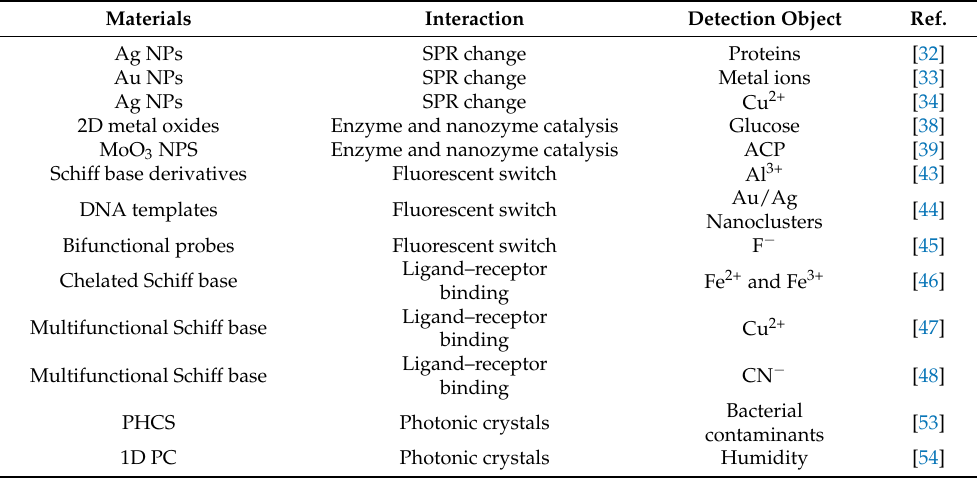
Table 1. The sensing mechanism and detection substances of various material-based colorimetric